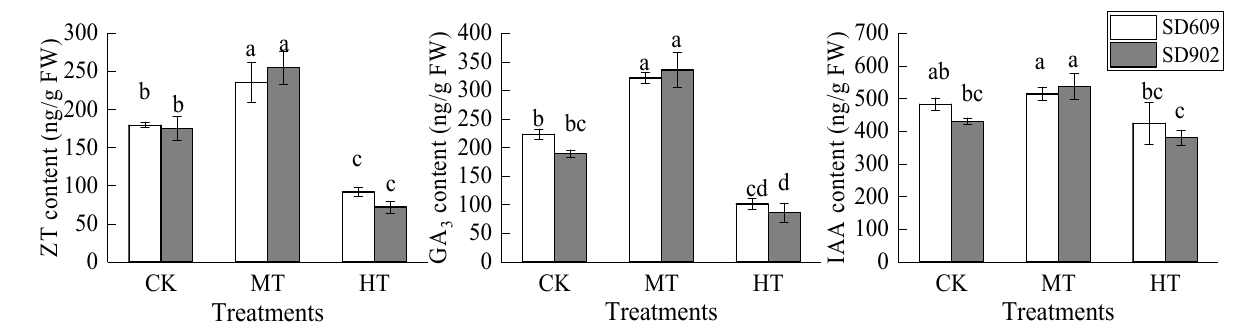
Figure 7. Effects of different root zone temperatures on the leaf hormone contents of SD609 and SD902. CK: 24 ◦ C, MT: 30 ◦ C, HT: 36 ◦ C (root zone temperature). Notations of a, b, c, and d above bars indicate homogeneous groups ( α = 0.05).